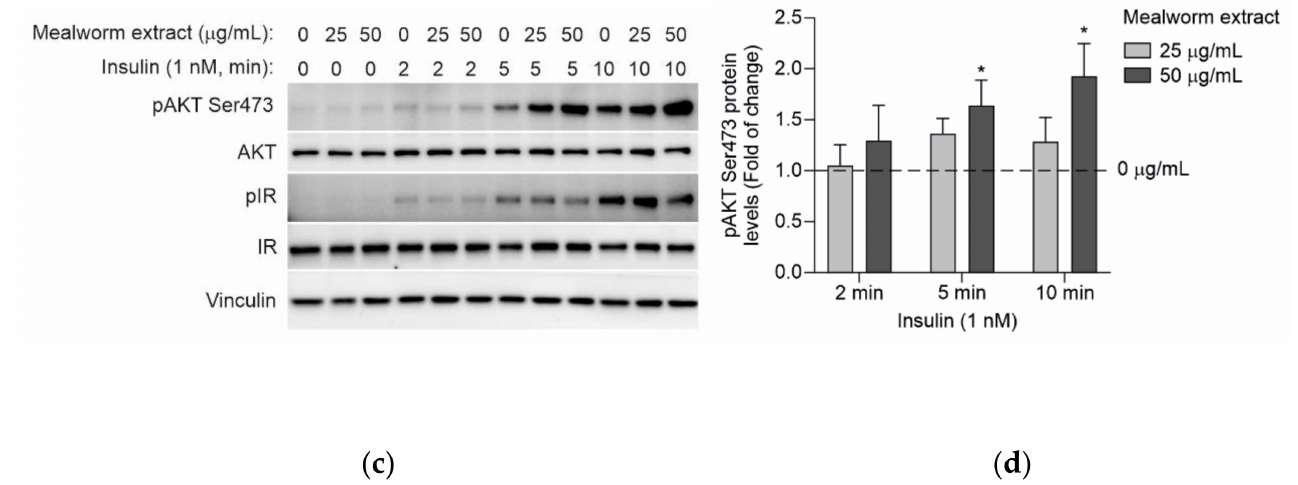
Figure 5. Mealworm extract treatment enhanced insulin signaling response in mouse primary hep- atocytes. ( a ) Mouse primary hepatocytes were treated with mealworm extract at 25 and 50 µ g/mL in serum − free DMEM (5.5 mM glucose) medium for 24 h prior to 5 nM insulin stimulation during the indicated time periods. Representative Western blot images for phospho-AKT (Ser473), total AKT, phopho-IR and total IR were shown. Vinculin was used as a loading control; ( b ) Densitometric quantification of phospho-AKT (Ser473) protein levels from A; ( c ) Mouse primary hepatocytes were treated with mealworm extract as described in A prior to 1 nM insulin stimulation. Representative images for phospho-AKT (Ser473), total AKT, phospho-IR and total IR were shown. Vinculin was used as a loading control; ( d ) Densitometric quantification of phospho-AKT (Ser473) protein levels from ( c ). For ( b ) and ( d ), values correspond to mean ± SEM ( n = 6). p < 0.05 (*), p < 0.01 (**) versus 0 µ